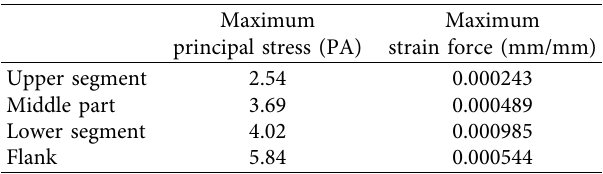
Table 1: Stress and strain distributions of nasal bone and its surrounding parts.